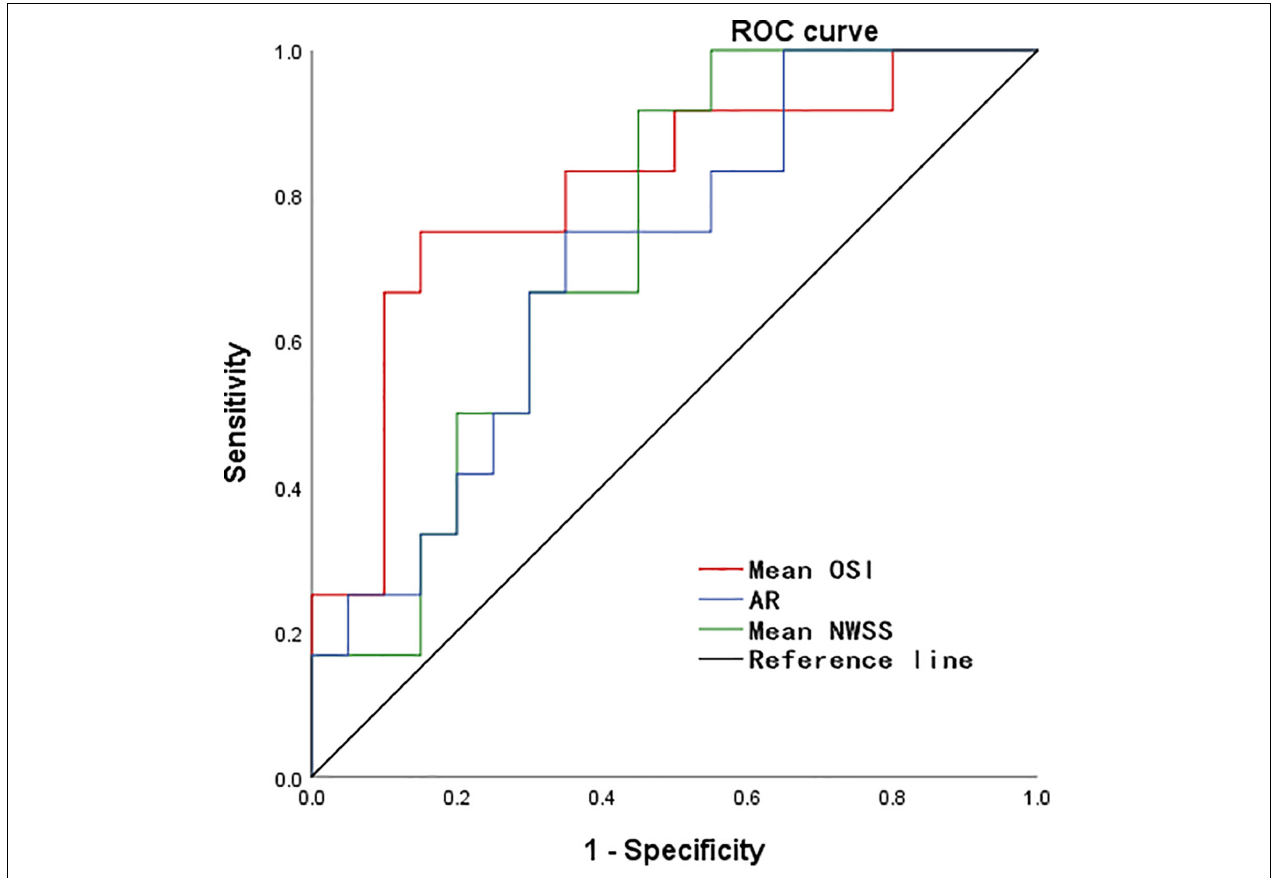
FIGURE 2 | The ROC curve for predicting PAA rupture. ROC, receiver operating characteristic, NWSS, normalized wall shear stress; OSI, oscillatory shear index; AR, aspect